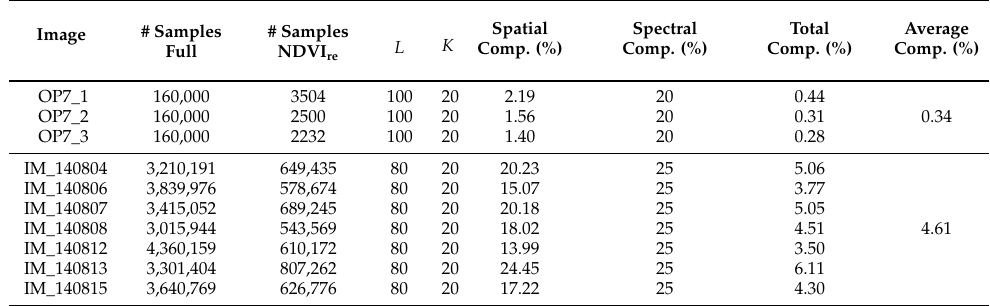
Table 3. Achieved compression for combined spatial and spectral DR.